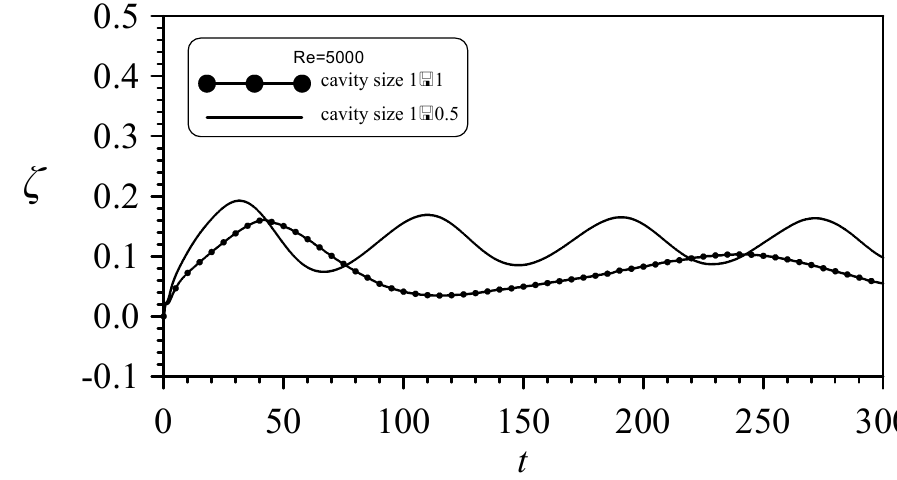
Figure 17. Time varying free-surface elevations for Re = 5000 at Fr = 1 with different cavity depth.